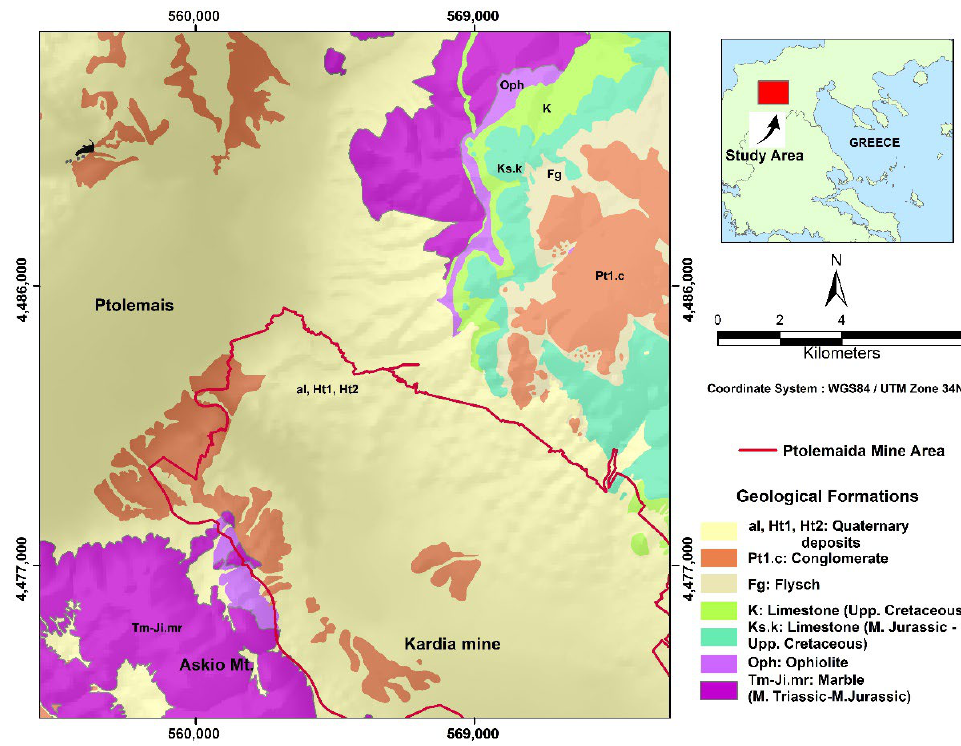
Figure 3. Simplified geological map of the Ptolemais area, located SE of the city of Ptolemais (based and modified on IGME geological sheet, Ptolemais 1:50,000 [23,24].